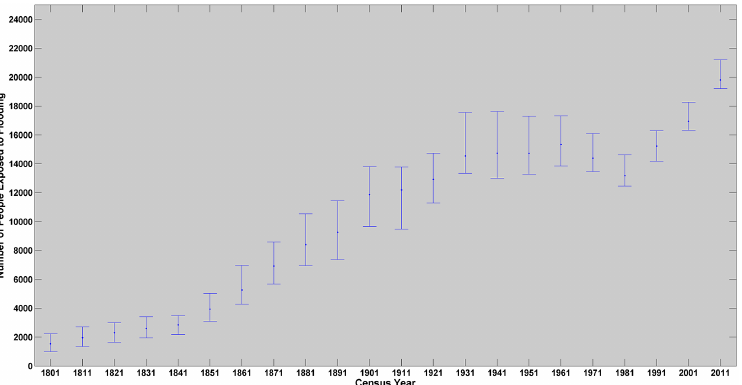
Figure 7. Estimated number of people exposed to flooding in Portsea (1 in 200 year recurrence interval, no defences). Error bars represent uncertainty in estimated rate of sea level change, population distribution and population size.